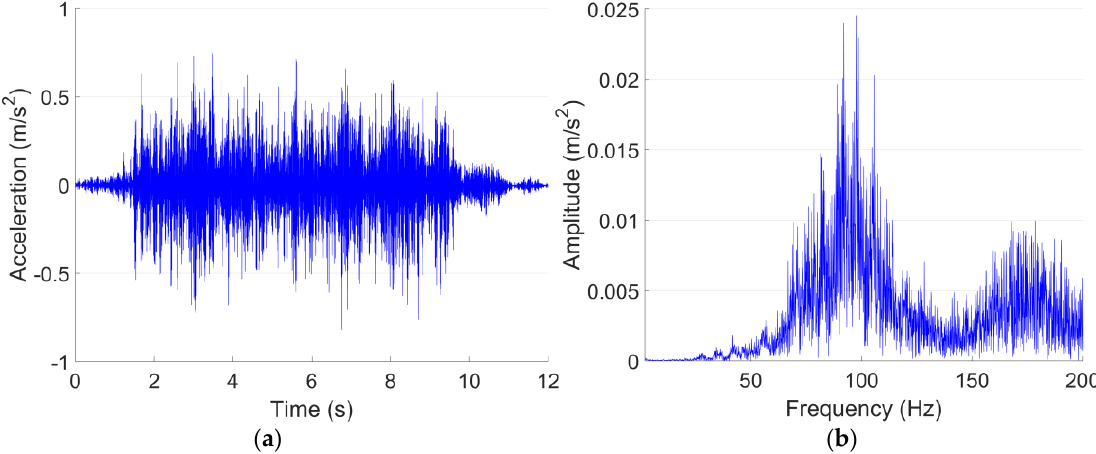
Figure 3. Typical tunnel wall acceleration responses in time ( a ) and frequency ( b ) domain in Line A.